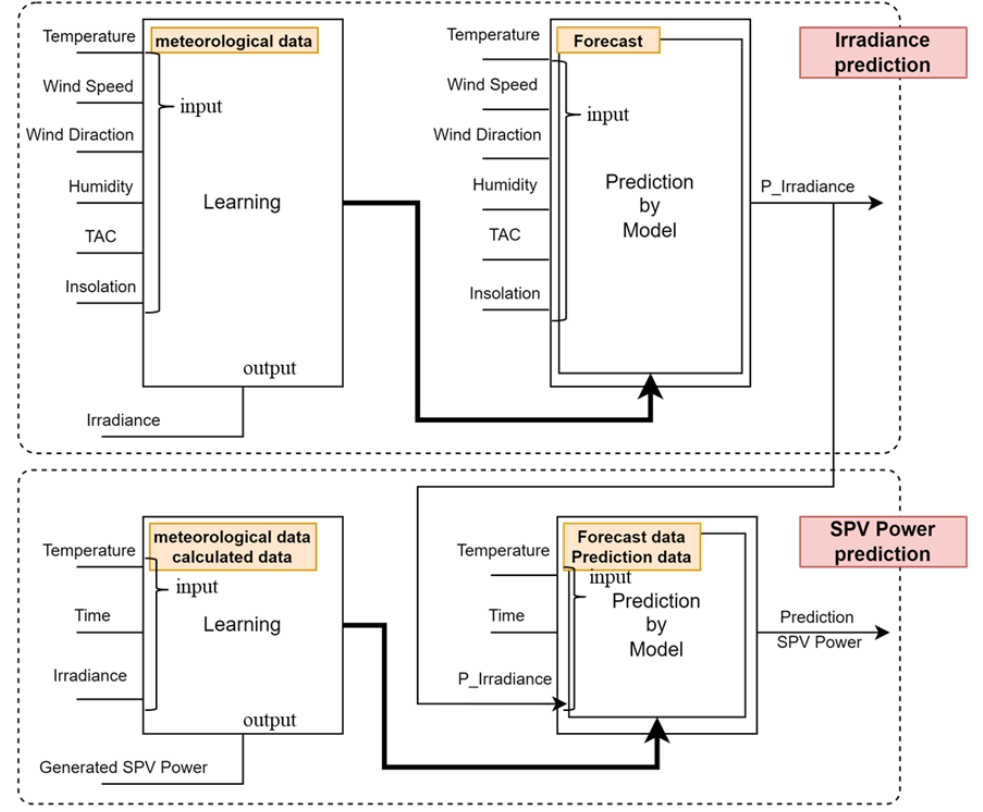
Figure 10. SPV Power Plant Model (lower notice box) and prediction irradiance input